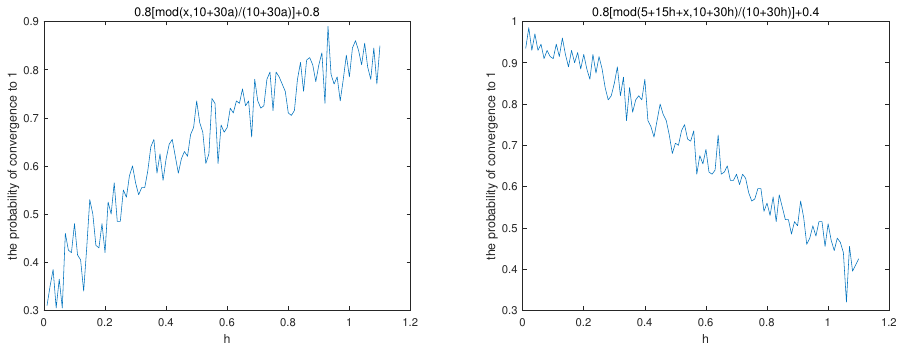
Figure 7. The probability that opinions converge to 1. ( left ): { b i ( t ) } are index periodic functions; ( right ): { b i ( t ) } are index periodic